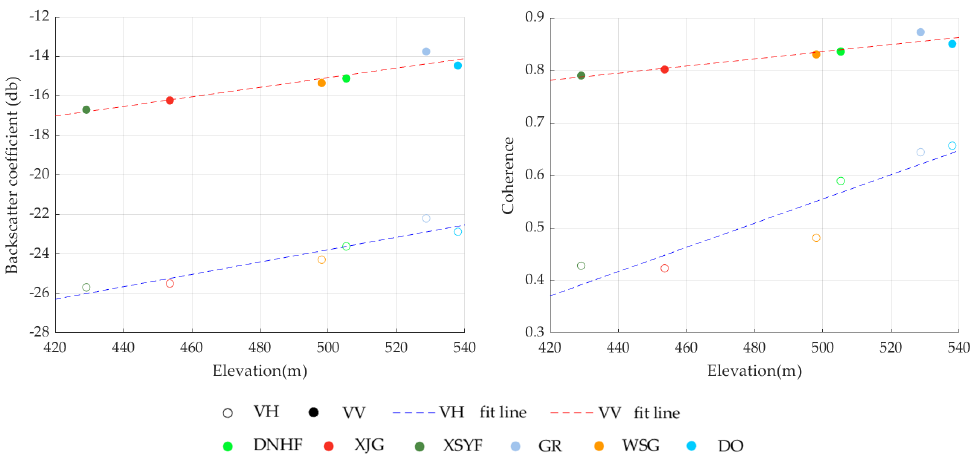
Figure 9. The relationship between averaged elevation and the averaged backscatter metrics of the six rock units (the elevation data is obtained from SRTM).